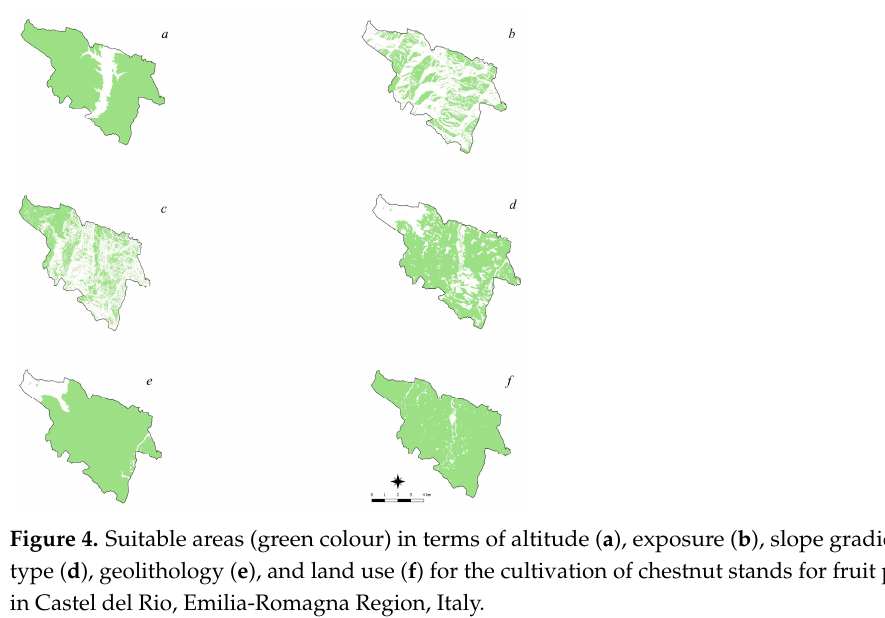
Table 3 . Main morphological, physical, and chemical features of soil profiles dug within the land units 2, 3, and 4 of Castel del Rio, Emilia ‐ Romagna Region, Italy.